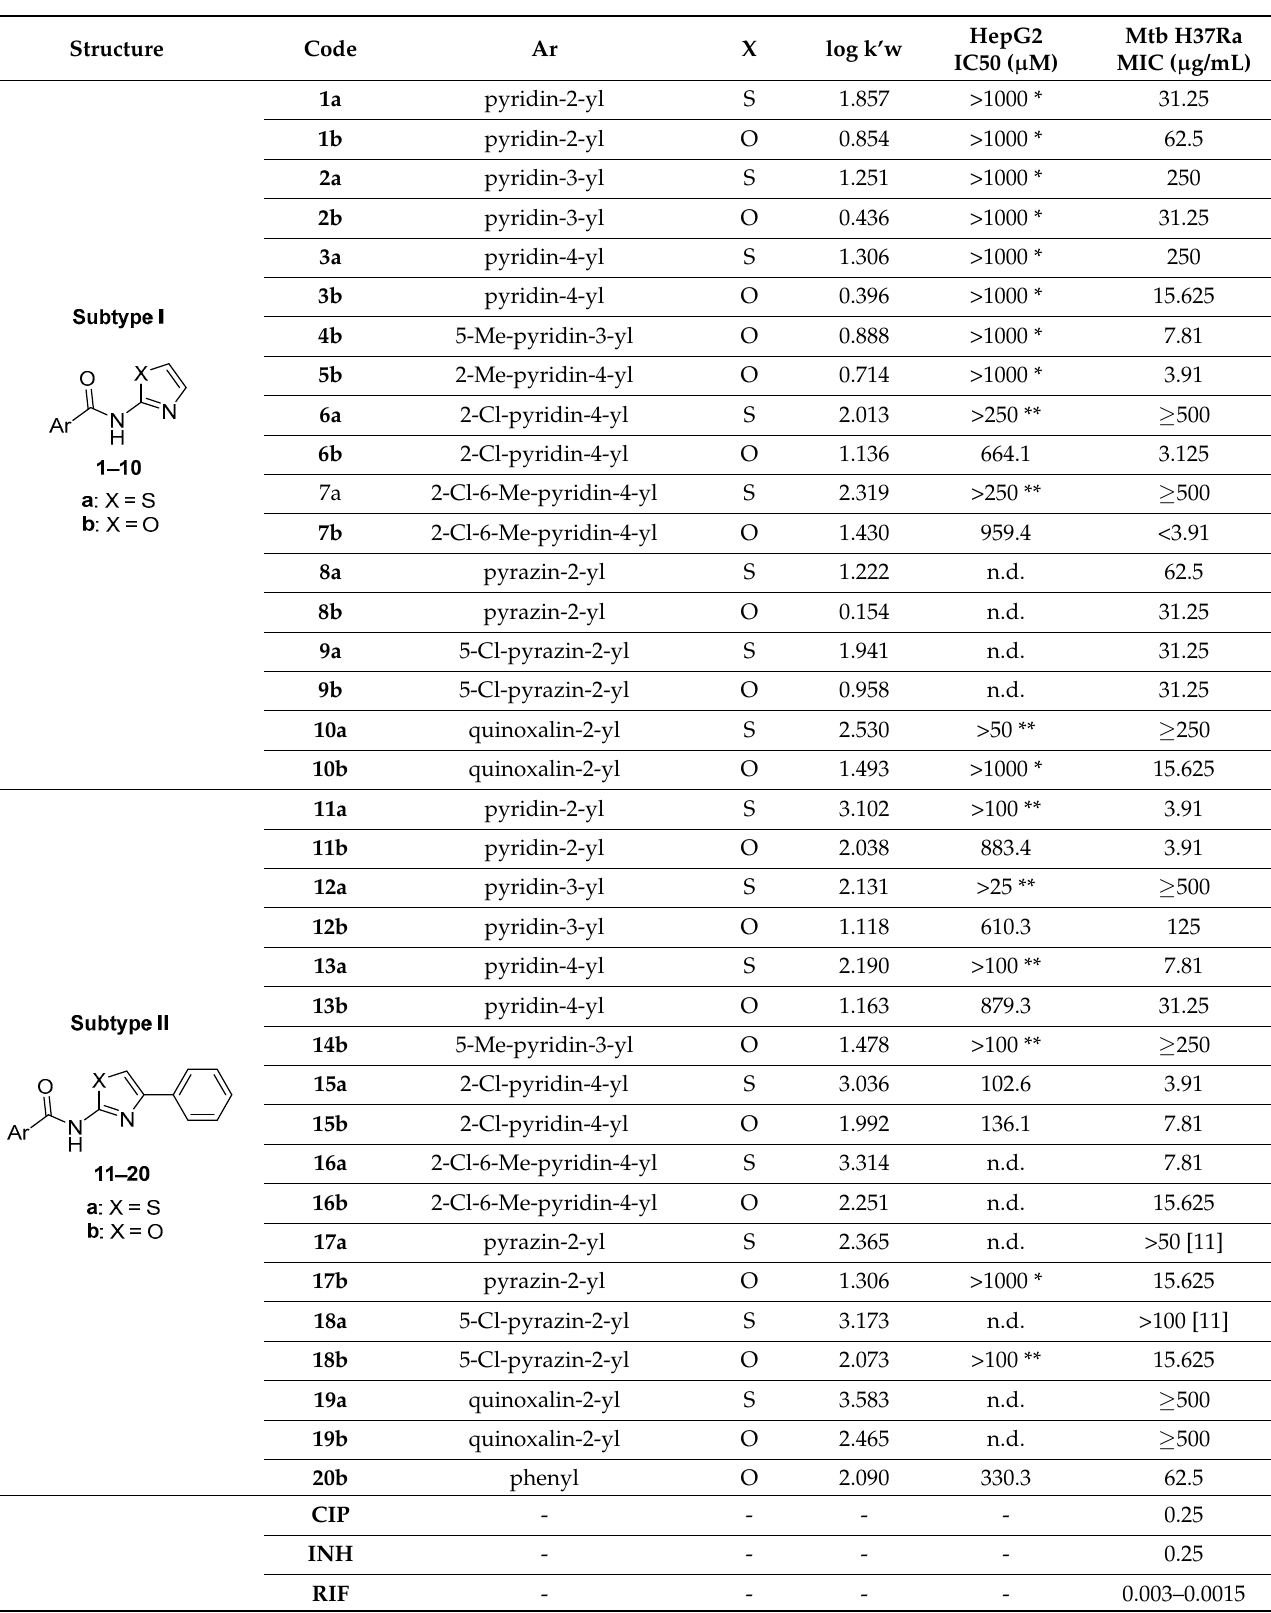
Table 1. Structures, log k’ w , HepG2 cytotoxicity, and MIC against Mtb H37Ra of the title compounds. Figure 2. Synthetic procedures used to prepare title compounds. Condition a: (for X = S) 1.1 eq. urea, in EtOH, reflux 2 h; b: (for X = O) 10 eq. urea, in MeCN, reflux 16 h or in DMF, 120 °C 2 h; c : 1 eq. Structure